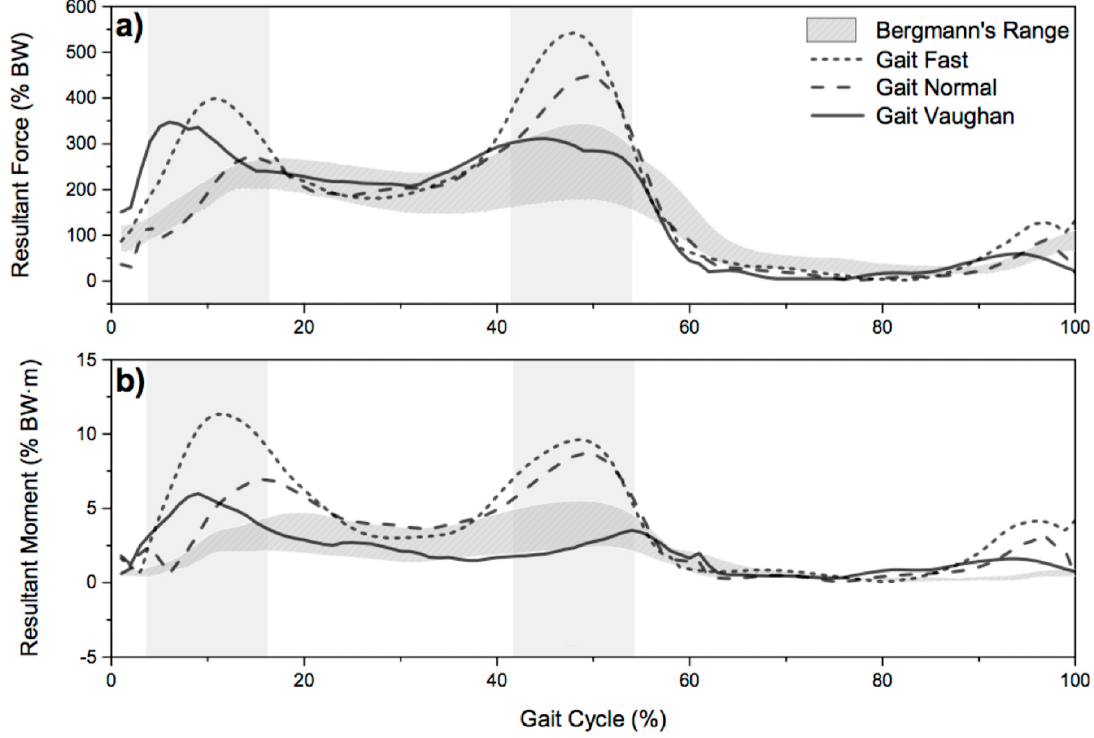
Figure 3. Comparison between in silico resultant force ( a ) and resultant moment ( b ) from three gait types and the in vivo values obtained by Bergman [14]. 196